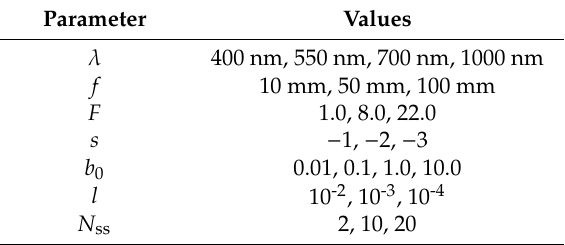
Figure A2. Deviation of the focal plane peak irradiance by using simplification S1 and simplification S2. Table A1. Values of the parameters that were varied in order to create the plot of Figure